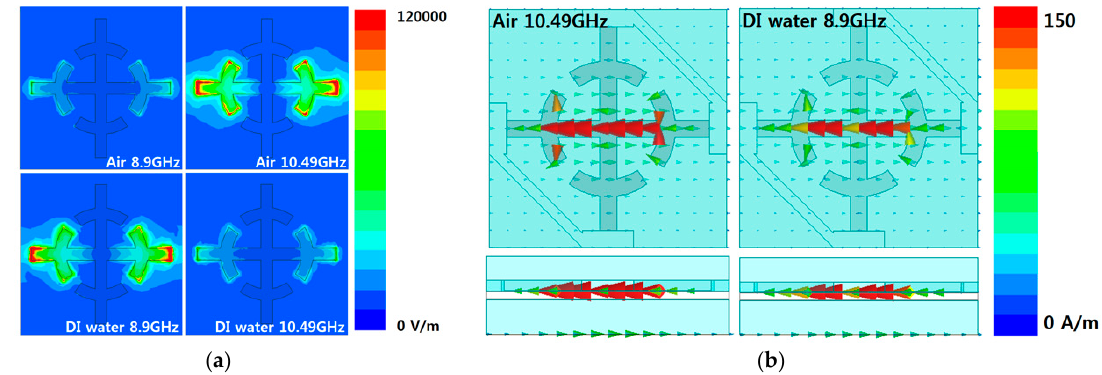
Figure 5. Simulated ( a ) electric field distributions and ( b ) vector current distributions.